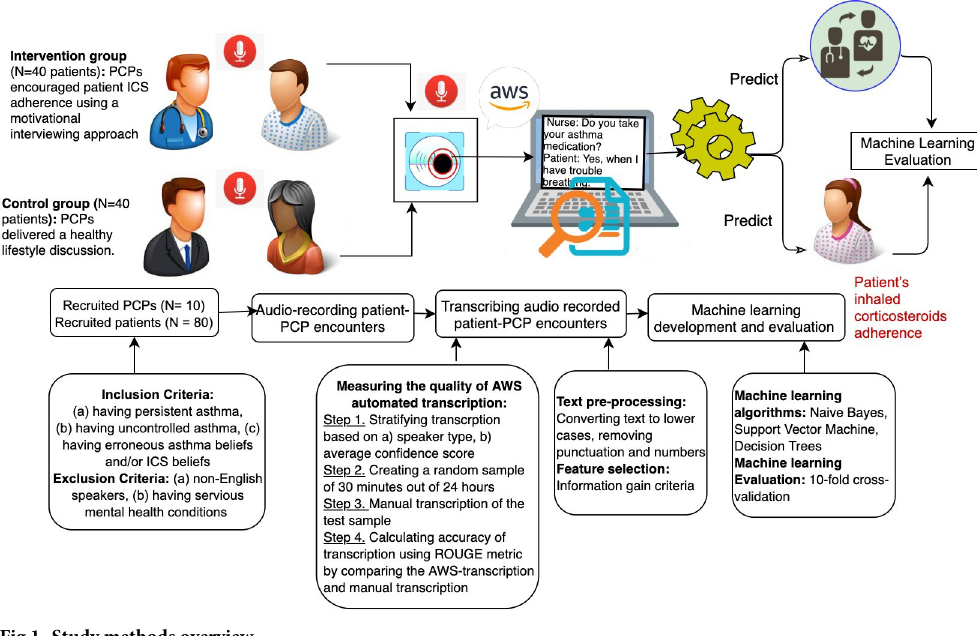
Fig 1. Study methods